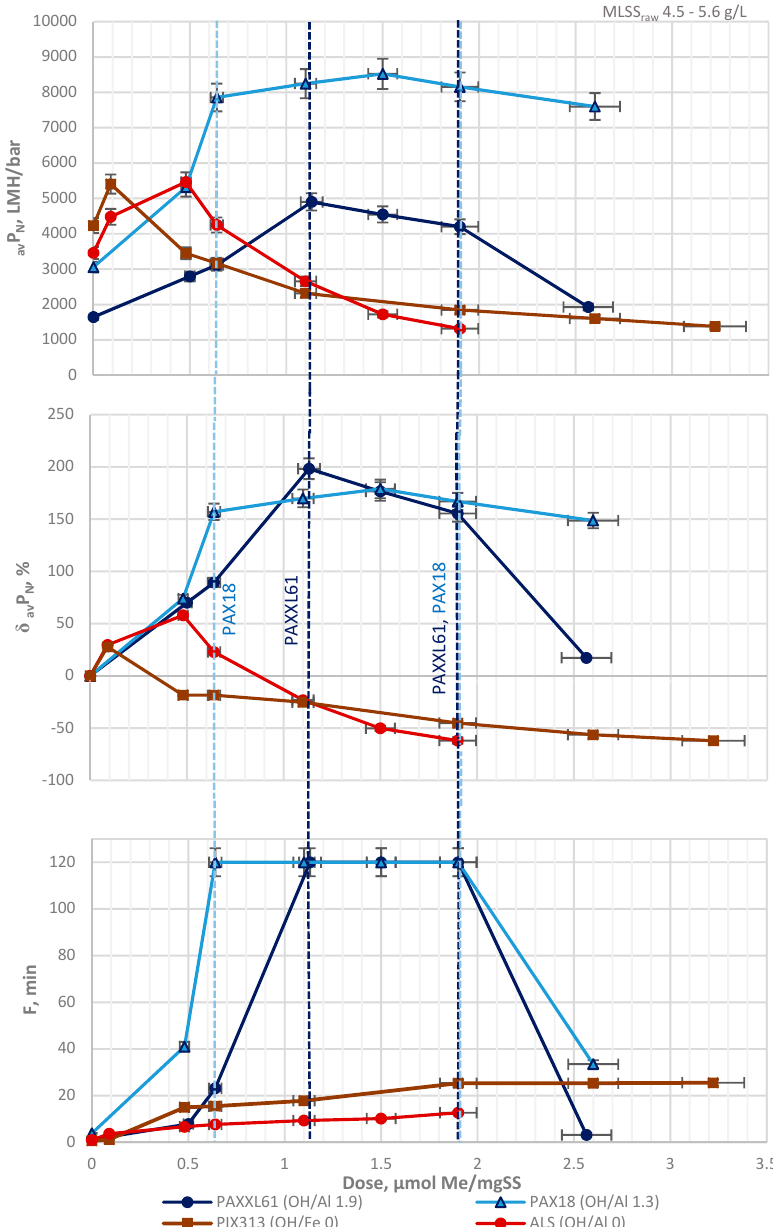
Figure 9. Relationship between the coagulant dose and the filtration performance according to normalized permeability, normalized permeability change and filtration time at fixed pH during the TRT.